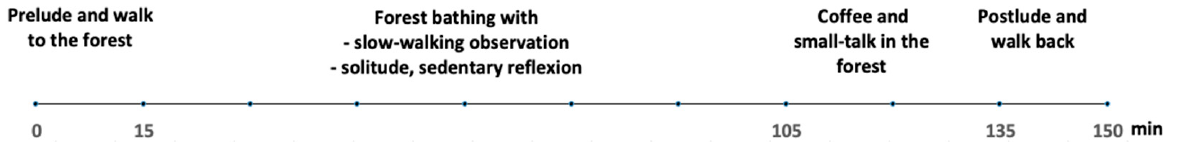
Figure 1. Timeline for each forest-bathing session, with arrangements and activity in the forest. There is a clear start and end of the session, where the participants walk to the forest and back from the forest. The forest bathing session is about 90 min, followed by a 30 min coffee/tea break, sum- ming up the day, before heading back to the parking lot.